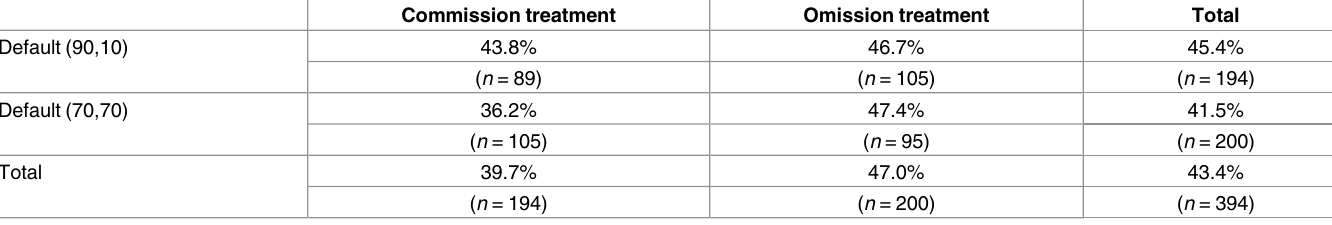
Table 2. Share of participants choosing the selfish allocation in the first